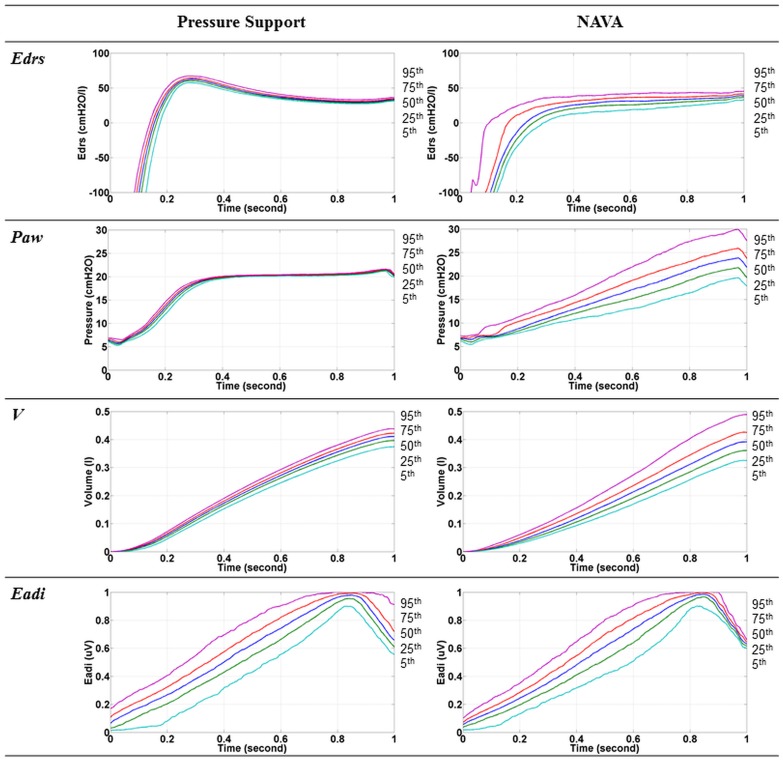
Time-varying Edrs, pressure, volume and electrical diaphragm activity (Eadi) curves for Patient 9 during PS (left) and NAVA (Right).The lines indicate the 5th (Light blue), 25th (Green) 50th (Blue), 75th (Red) and 95th (Pink) percentile of all breathing cycles. The sequence where 5th, 25th, 50th, 75th and 95th percentile line occurs is labelled at the side of each figure.